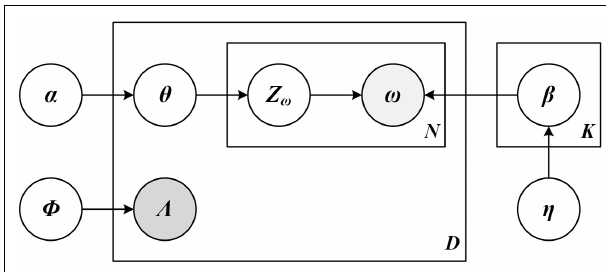
FIGURE 3 | The Labeled Latent Dirichlet Allocation (LDA) model of semantic recognition